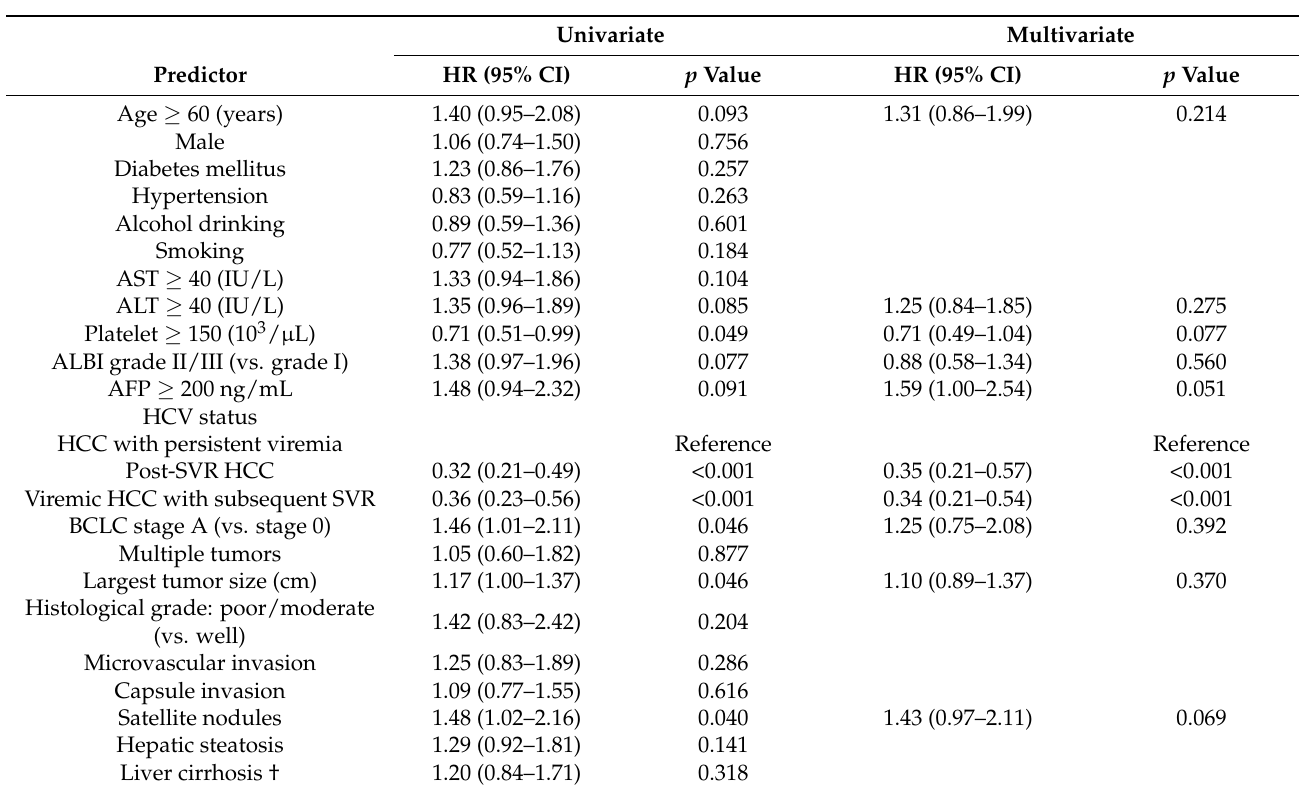
Table 4. Factors predictive of recurrence-free